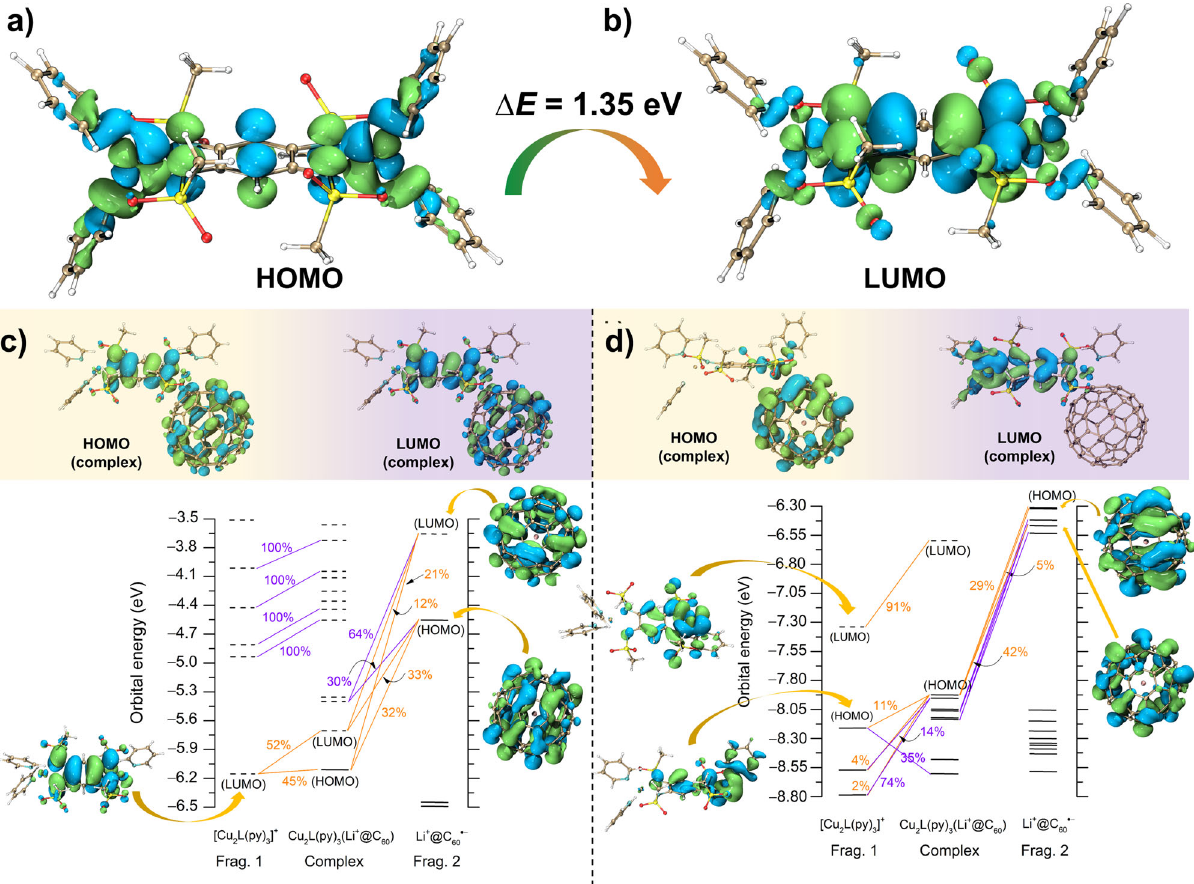
Fig. 6 Orbital calculations and generalised charge decomposition analysis (GCDA) for donor-acceptor bonded interactions. a HOMO of Cu 2 (L)(py) 4 . b LUMO of Cu 2 (L)(py) 4 . c Orbital interaction diagram and molecular orbitals in α electron form. d Orbital interaction diagram and molecular orbitals in β electron form. The black solid lines and dotted lines represent the occupied and virtual orbitals, respectively. The orange and violet lines represent